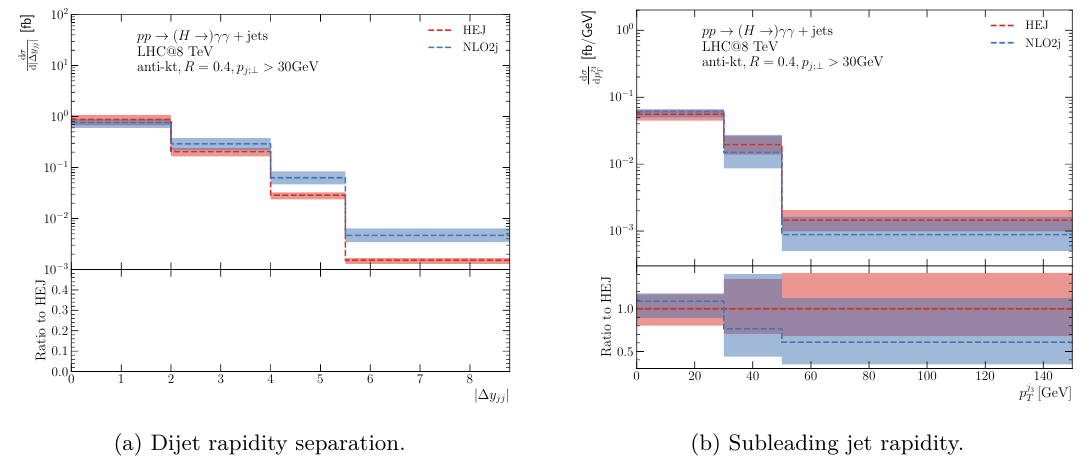
(a) Dijet rapidity separation. (b) Subleading jet rapidity. Figure 12. (a): dijet rapidity separation. (b): azimuthal angle difference between the leading 2 jets. This shows the distributions from figures 10a and 11b, where now we only show the QCD contribution. As before, the 2-jet HEJ predictions are rescaled by the inclusive cross section ratio σ NLO2J /σ HEJ 2J